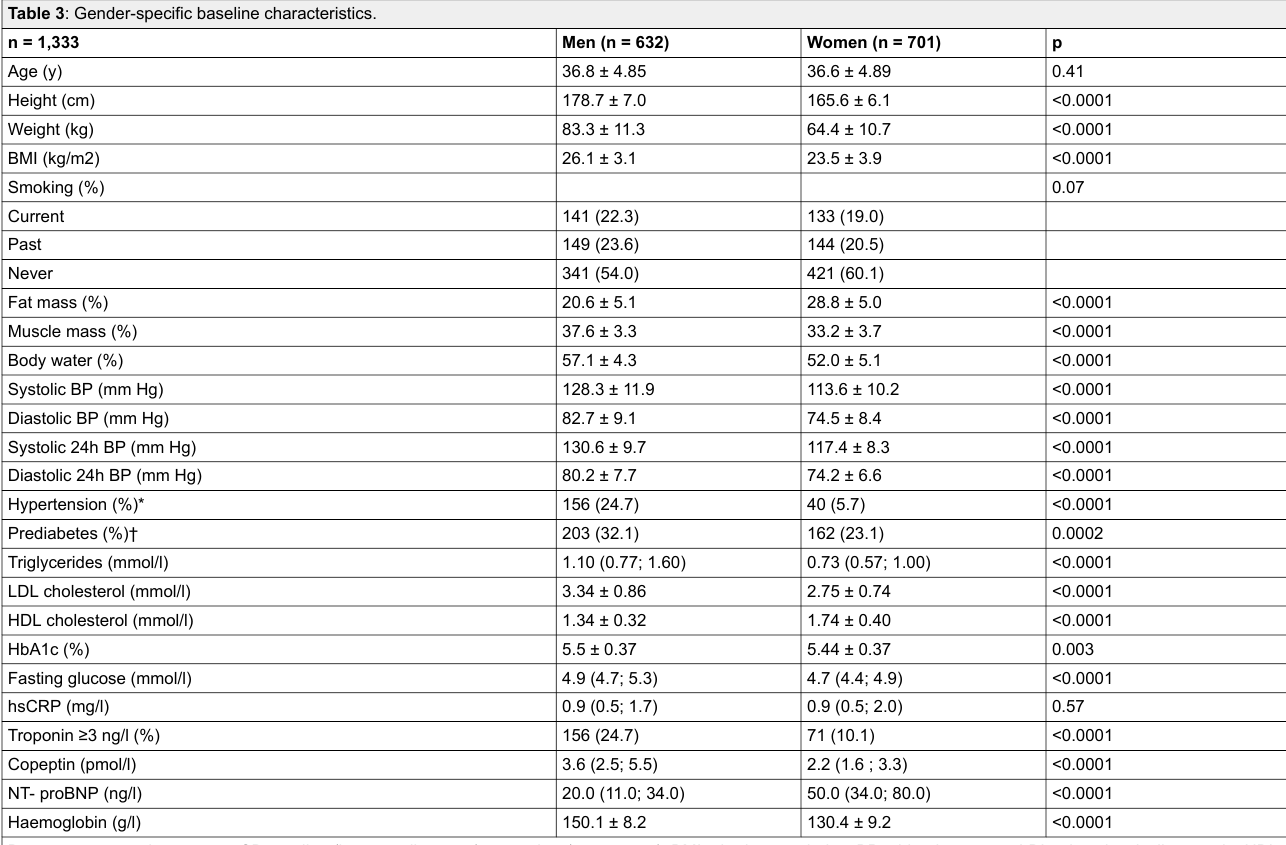
Table 3 : Gender-specific baseline